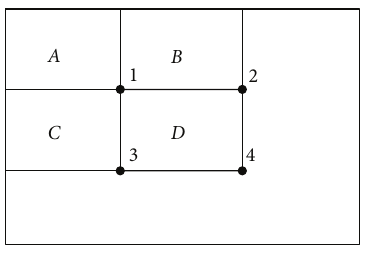
Figure 2: Integral image blocks.